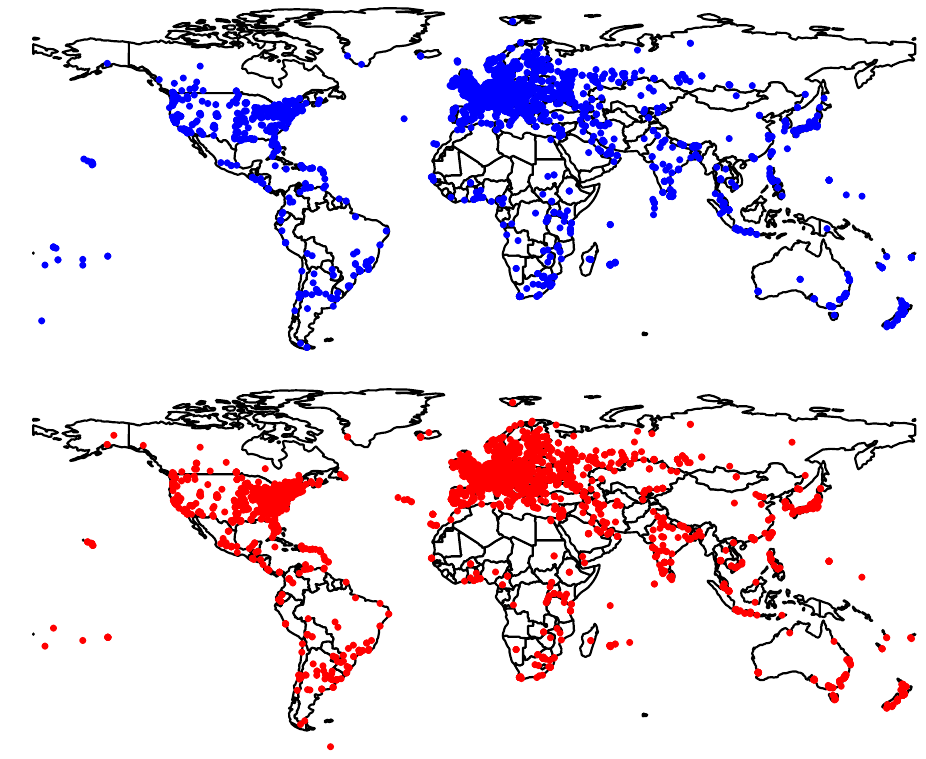
Figure 2. Ground truth global distribution in 2016 (blue) and 2021